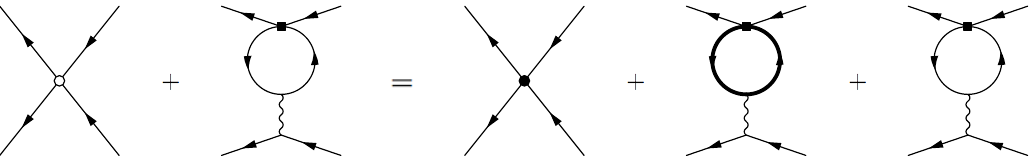
Table 5 . Operators Q i and coe(cid:14)cients (cid:24) i for the semileptonic part of the e(cid:11)ective Lagrangian L EW involving charged currents. For up-type quarks the indices rum from 1 to 2. The (cid:24) i coe(cid:14)cient for the Hermitian conjugate operator can be easily derived.